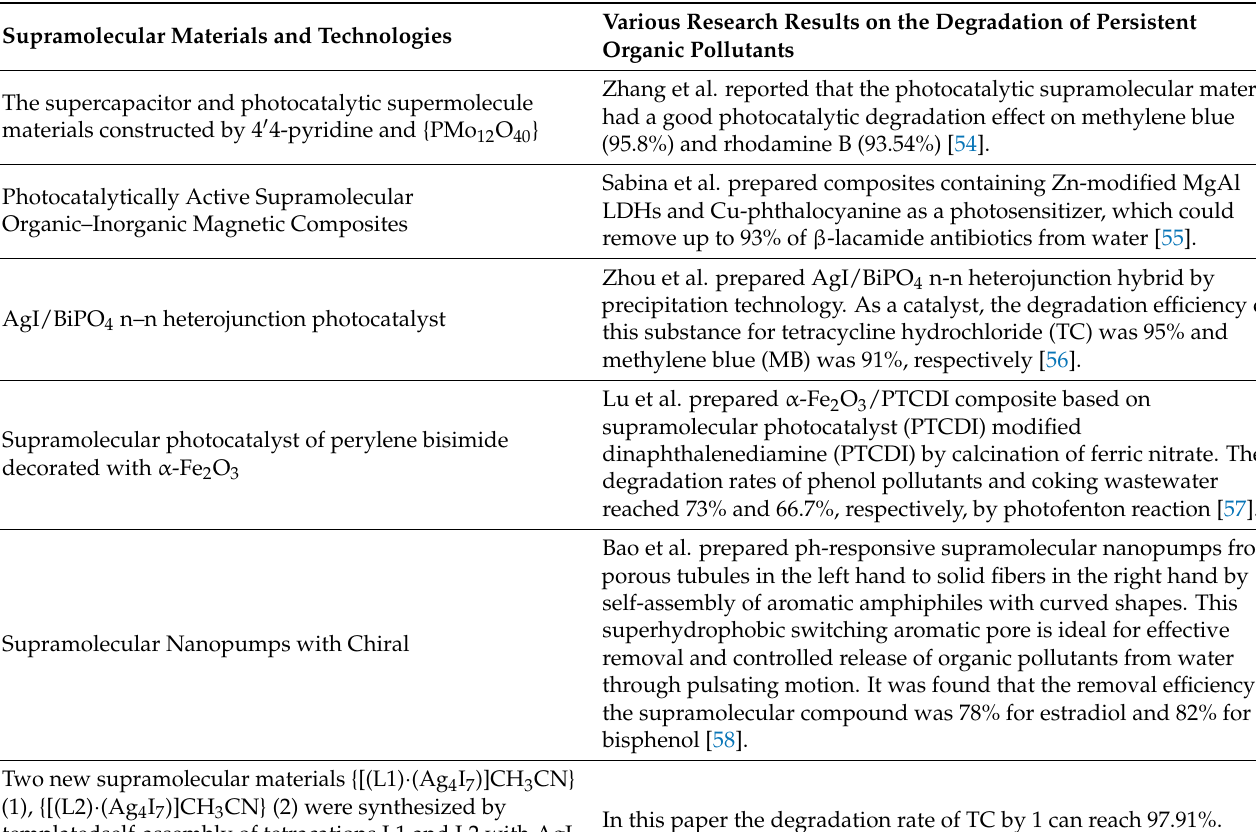
Table 1. Research results on the degradation of persistent organic pollutants by supramolecular